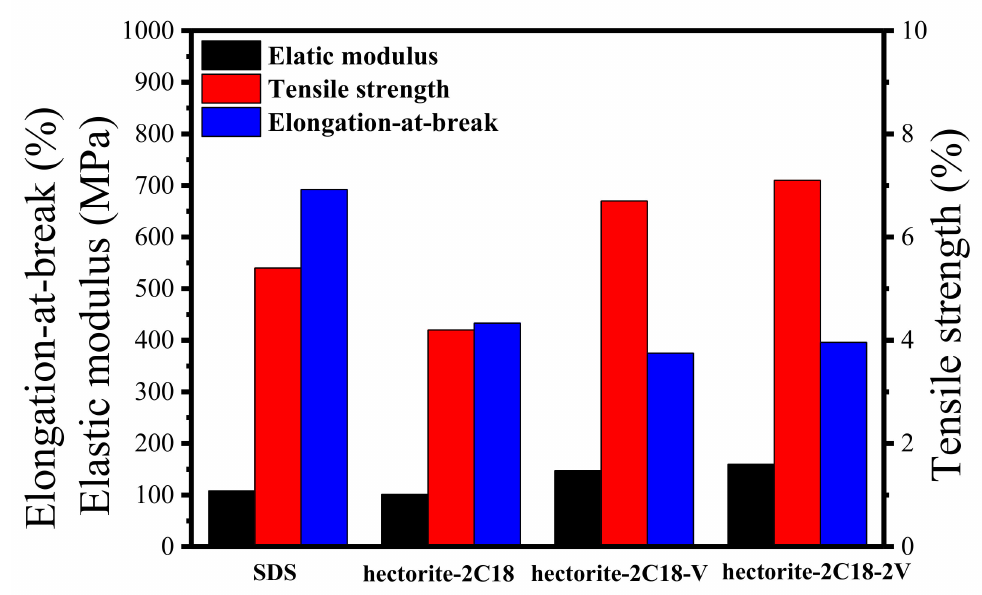
Figure 8. Elastic modulus, tensile strength, and elongation-at-break of polyacrylate latex films prepared with SDS (1 wt%), Laponte-2C18 (3 wt%), hectorite-2C18-V (3 wt%), hectorite-2C18-2V (3